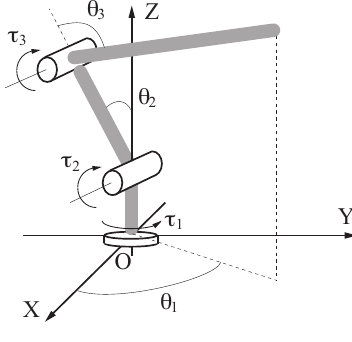
Figure 2. Schematic of a three-link robot